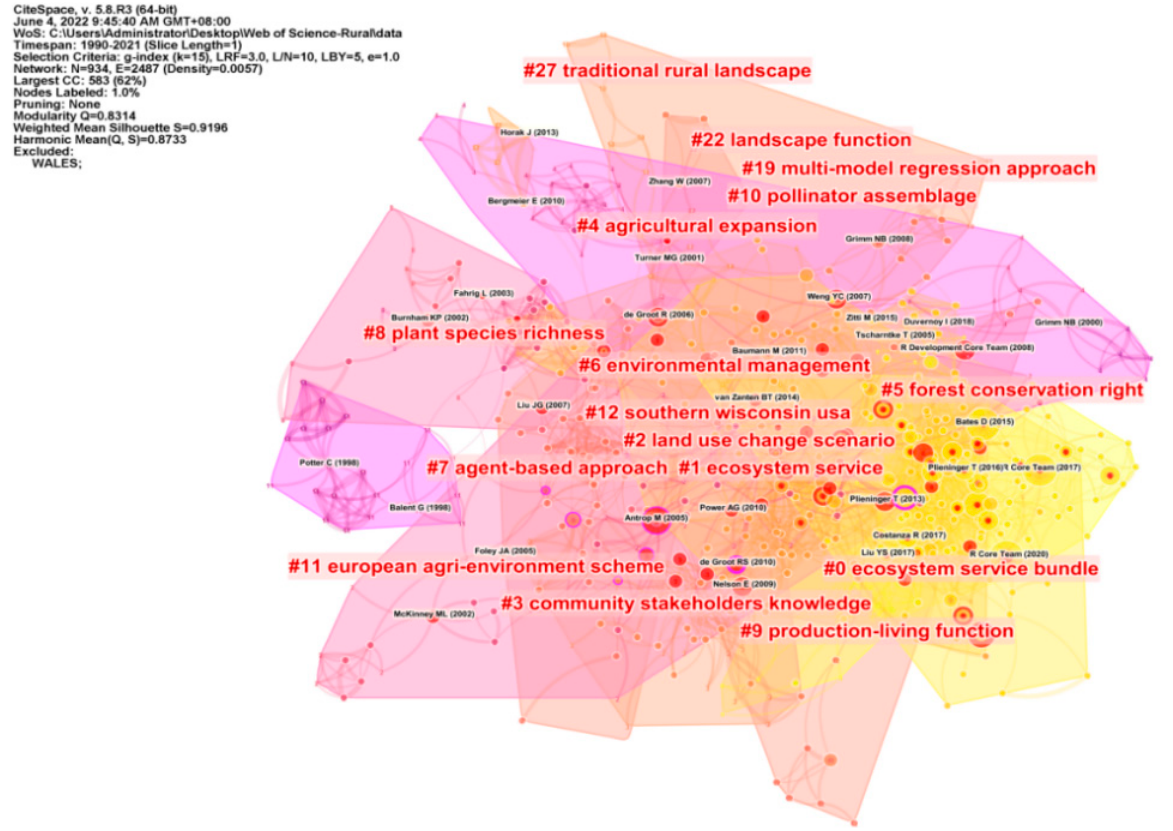
Figure 12. Clustering of co-citation references.